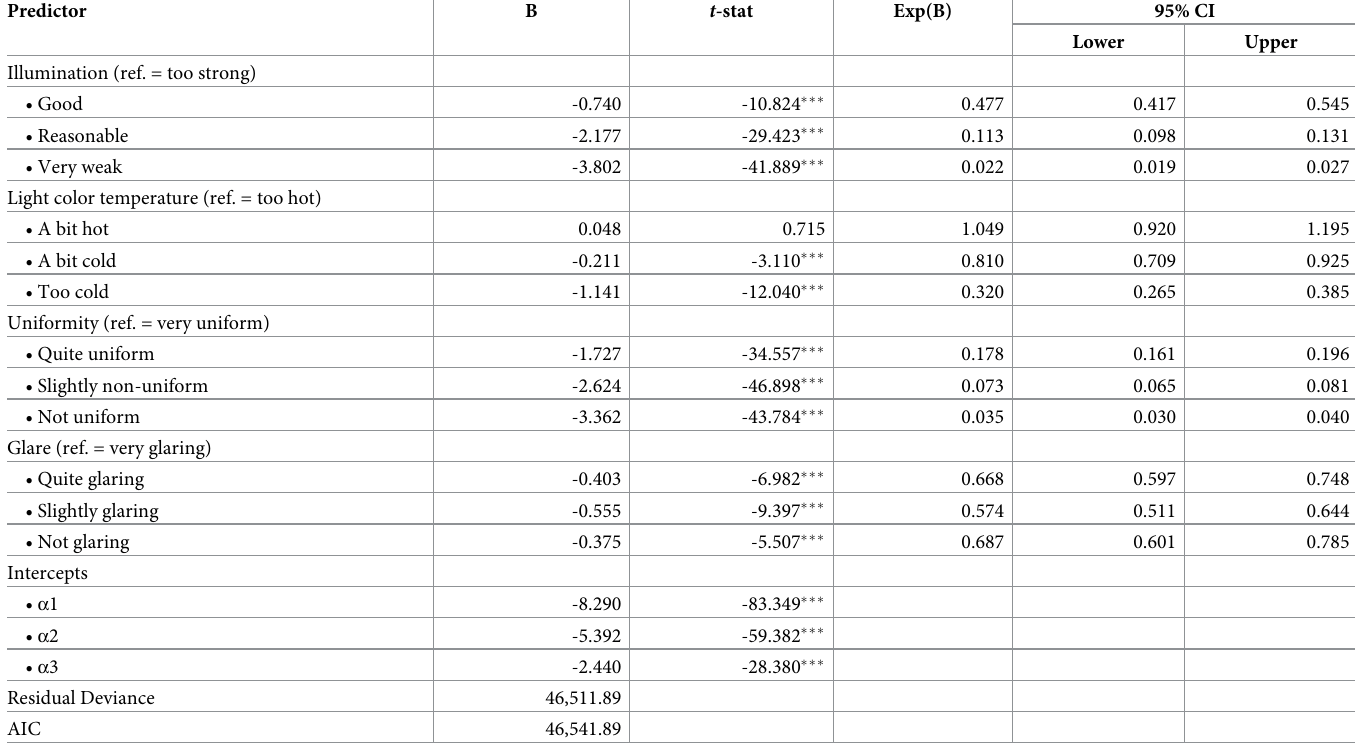
Table 3. Factors affecting FoS in the neighborhoods surveyed (method: Multiple ordinary regression; dependent variable–FoS on a 4-point Likert scale from 0 (very unsafe) to 3 (very safe); Model 1: Only PSL attributes are included. Predictor B t -stat Exp(B)